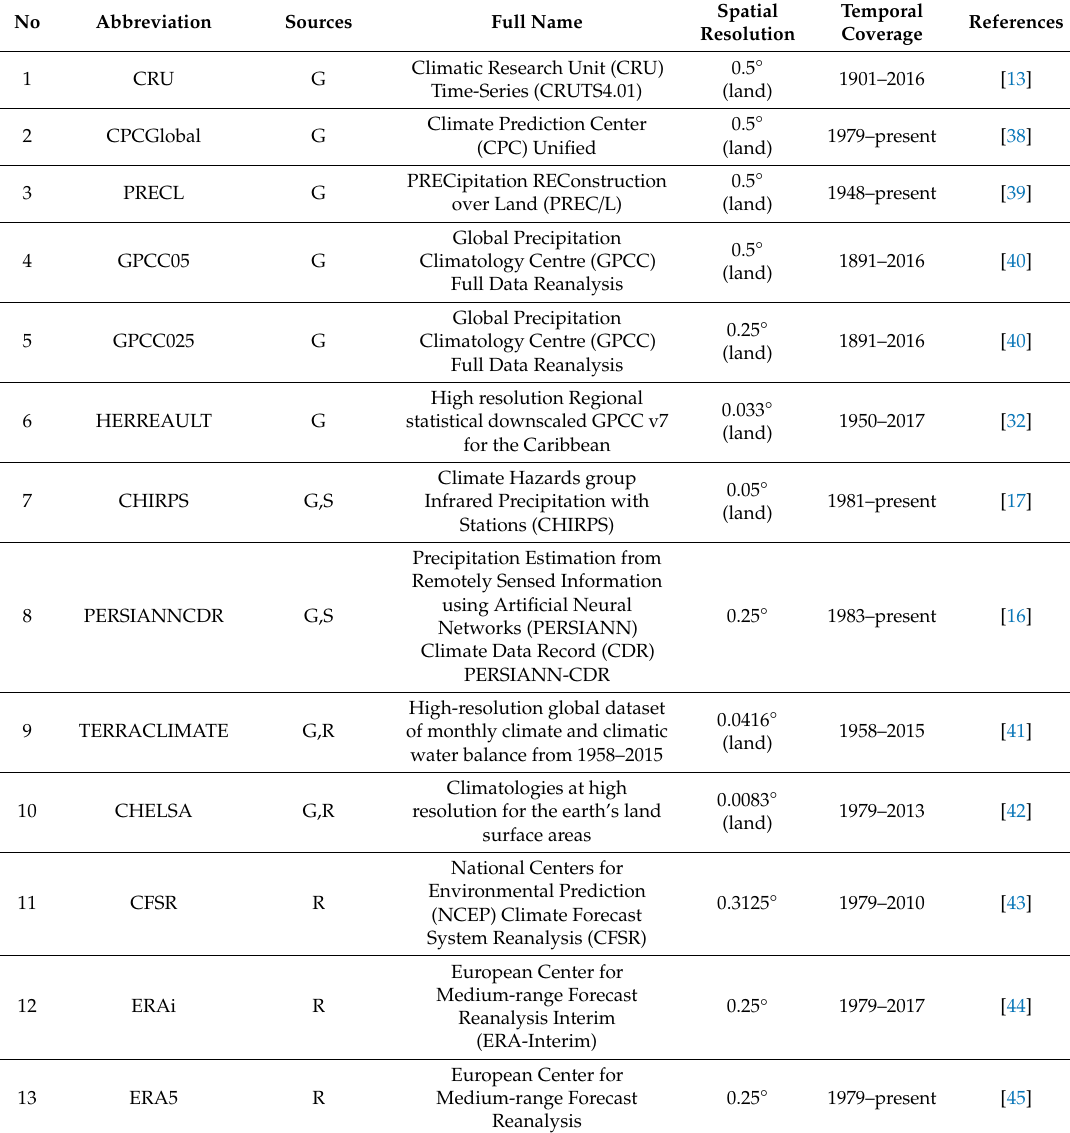
Table 1. Information on GPP used in this study. The abbreviations in column 3 are defined as follow: G, gauges; S, satellite; and R, reanalysis. The term land in the column 5 means the dataset is limited to land areas only. A detailed description of each GPP is provided as Supplementary